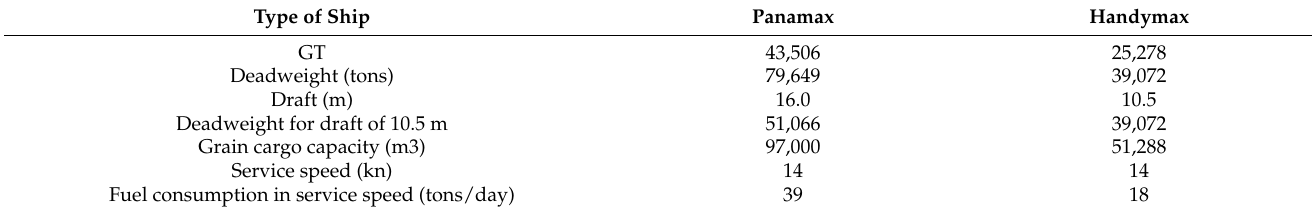
Table 3. Ship parameters taken into account in the carbon footprint calculation. Type of